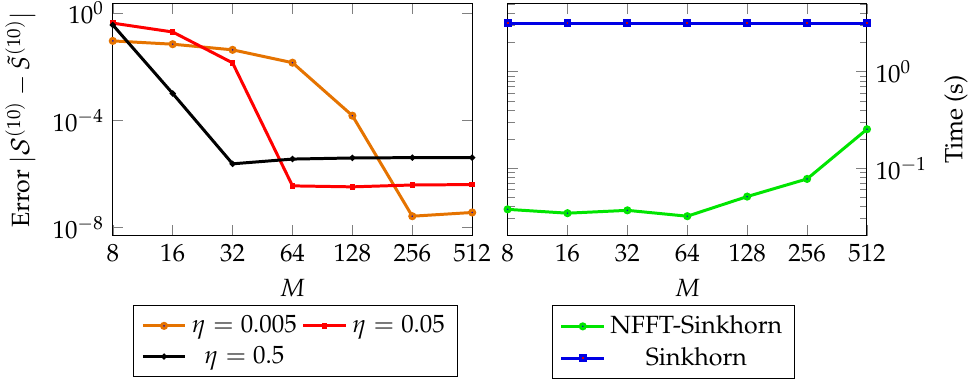
Figure 4. MOT η with tree-structured cost function, where d = 2, K = 10, N = 10,000, and p = 3. Left : Approximation error of S ( 10 ) between the Sinkhorn and the NFFT-Sinkhorn algorithm, depend- ing on the number of Fourier coefficients M of the NFFT. Right : Computation time in seconds.